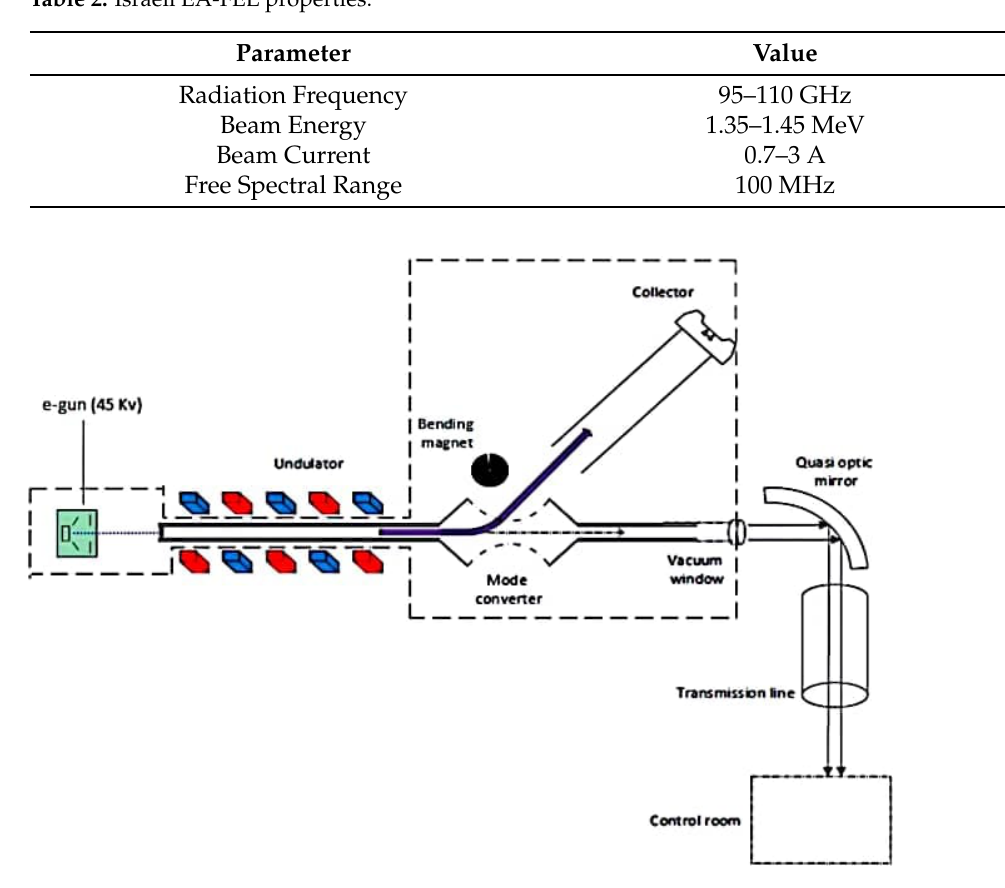
Figure 3. Schematic of the electrostatic accelerator